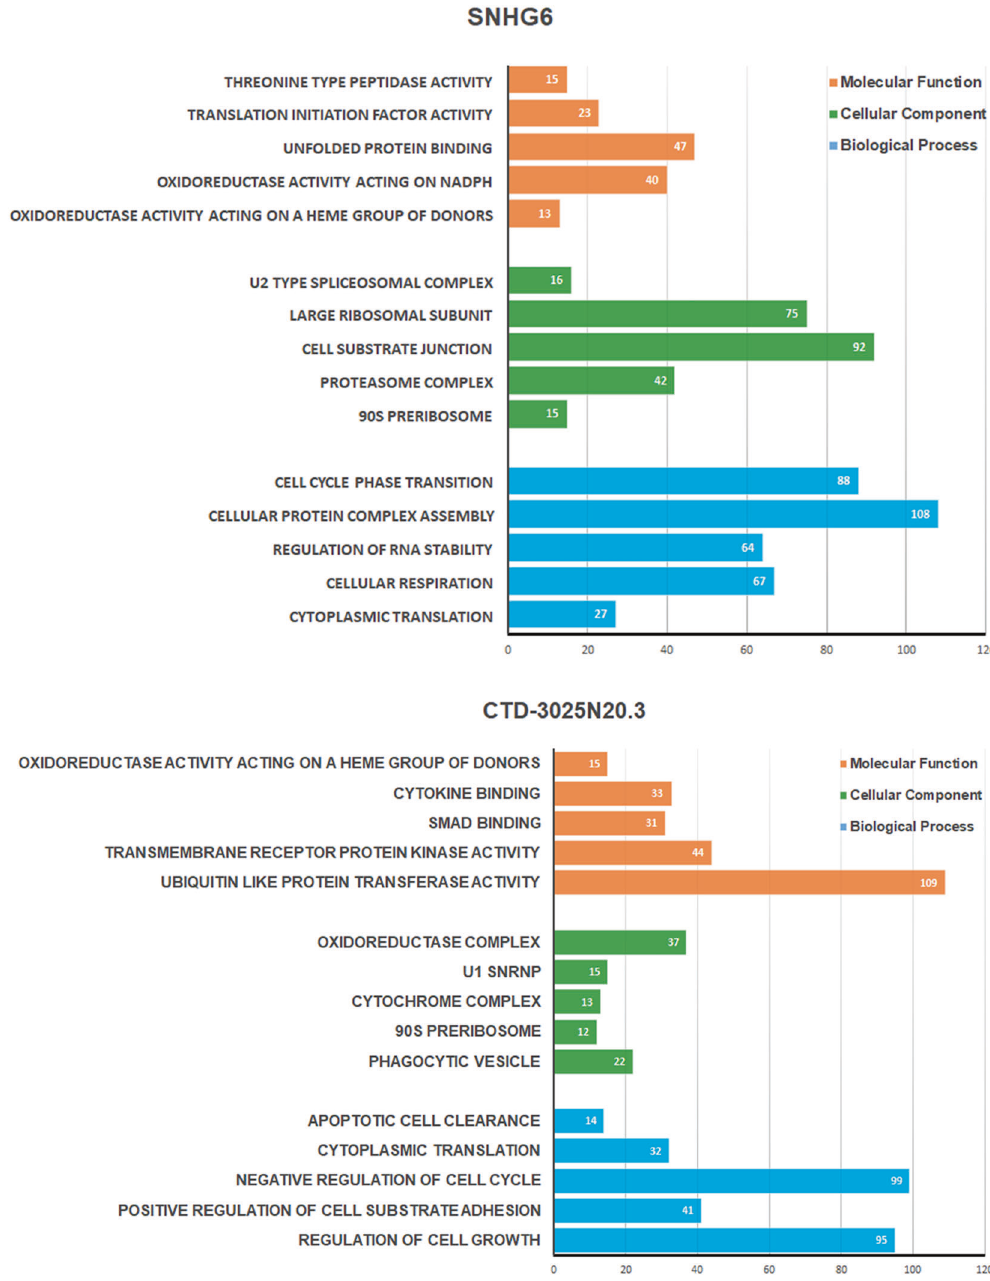
Fig. 6 GO functional enrichment analysis of lncRNAs. Functional enrichment for SNHG6 (up) and CTD-3025N20.3 (down) were partly